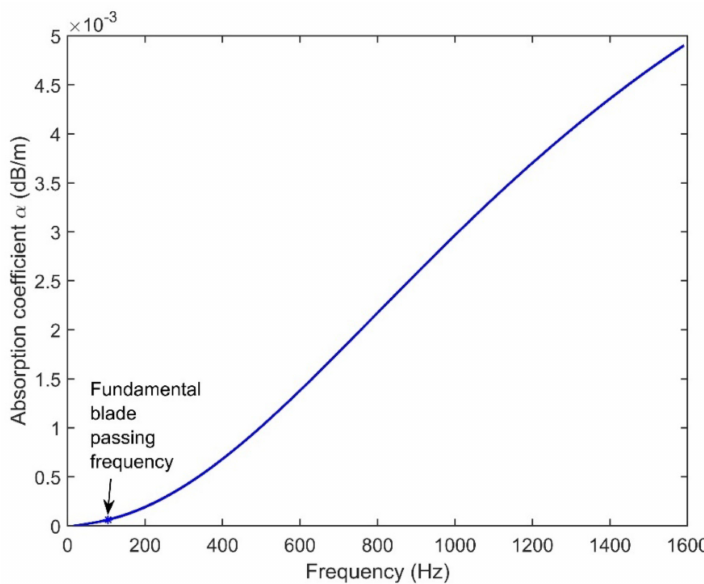
Figure 9. Sound absorption coefficient variation with